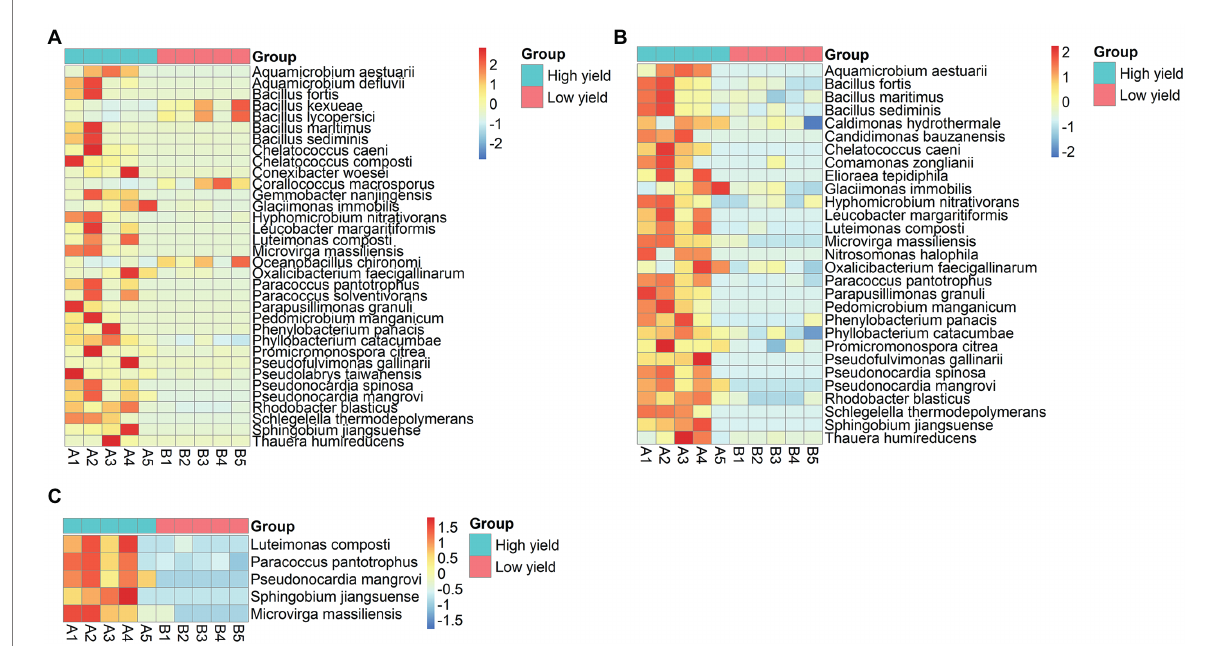
FIGURE 4 Heat-map demonstrating differentially abundant species between group A and group B analyzed by (A) DESeq2, (B) metagenomeSeq, and (C) merged results from both methods showing 5 species with the highest degrees of differential abundance. The row represents species, and the column represents the samples. The abundance of species corresponds to the color scale of the heat